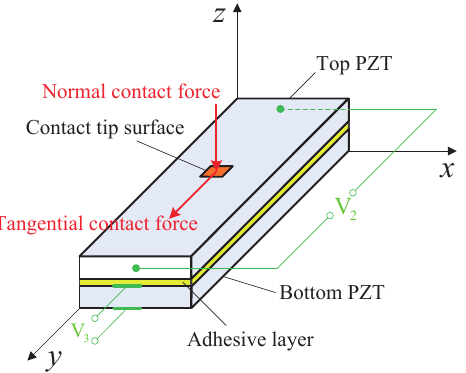
Figure 8. Schematic of the piezoelectric sensor used to measure frictional contact